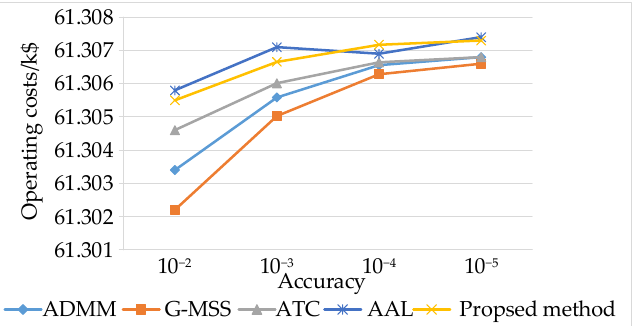
Figure 6. System operating cost with various algorithms under different accuracy.